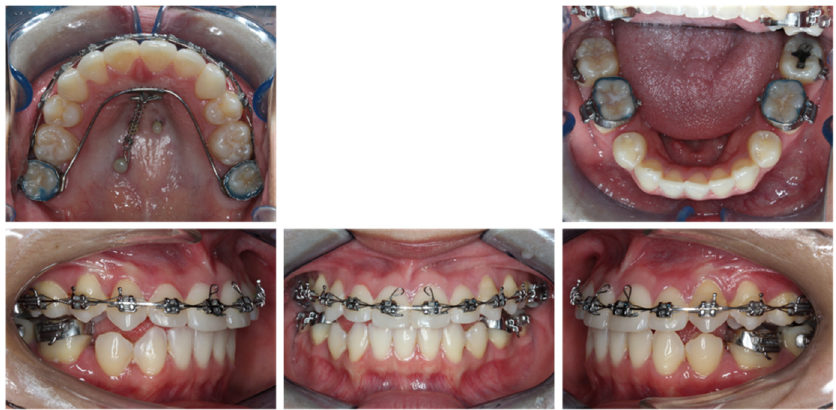
Figure 7. Thirteen-month progress facial and intraoral photographs.